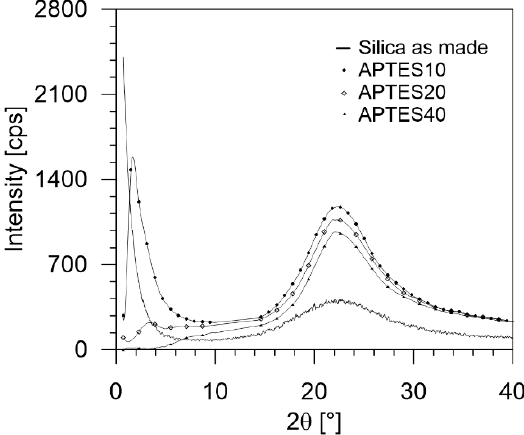
Figure 3. XRD spectra of the as-made and APTES-grafted silicas.